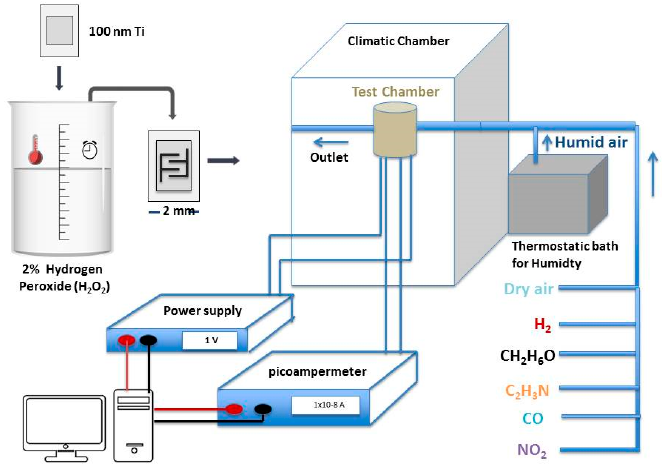
Figure 1. Schematic representation of experimental procedure and gas measurement system set up. A voltage of 1 V was applied to the active layer using an Agilent E3631A power